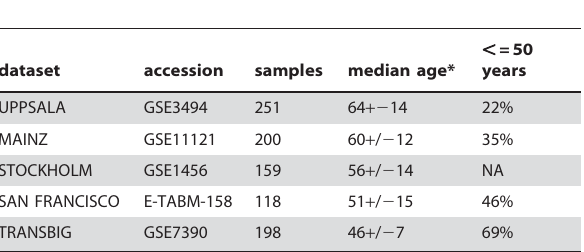
Table 8. Age distribution for five datasets.